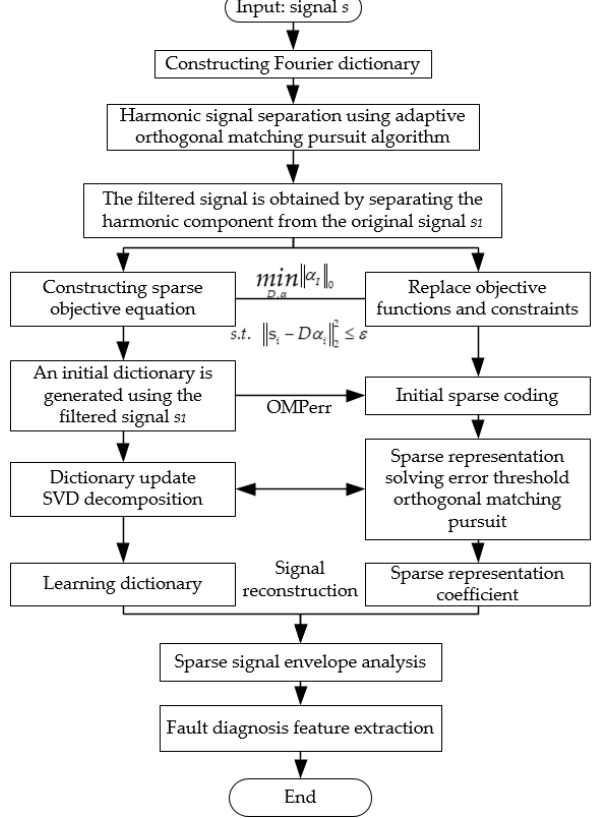
Figure 3. The flow chart of bearing fault feature extraction based on adaptive OMP and improved K-SVD.